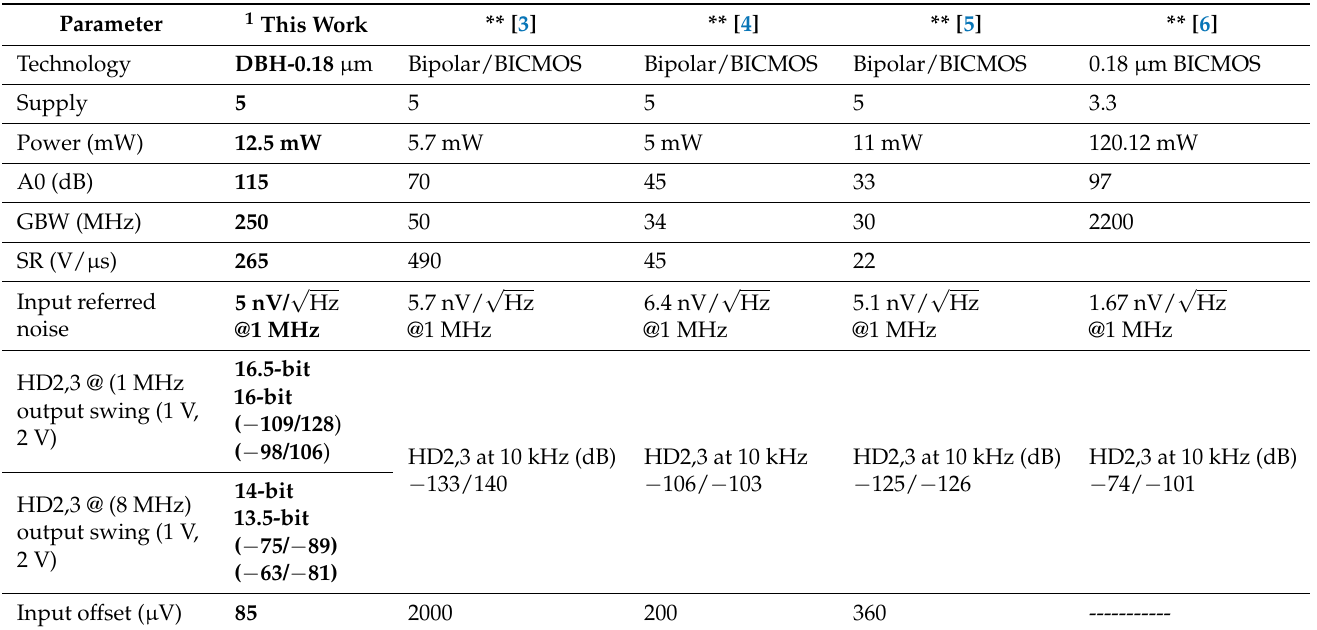
Table 2. The performance and comparison to the prior